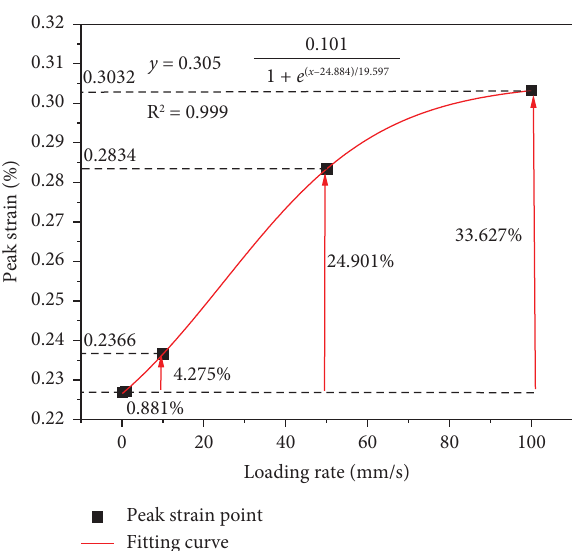
Figure 7: Curve of the number of crack variations.